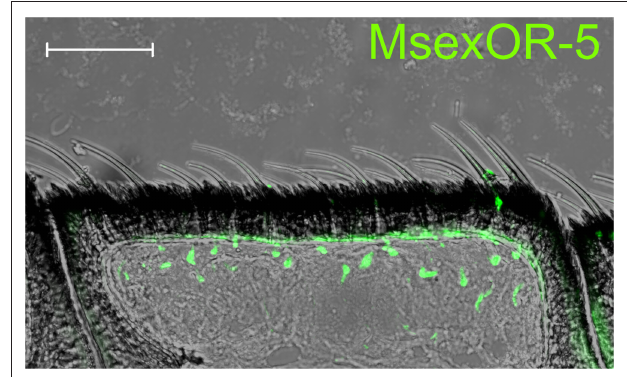
Figure 4 | MsexOr-5 expression in the female antenna. ISH using a biotin-labeled probe directed against MsexOR-5 on a longitudinal cryosection of the female M. sexta antenna. Labeled cells are associated with sensillar hairs. (Scale bar = 50 μm).